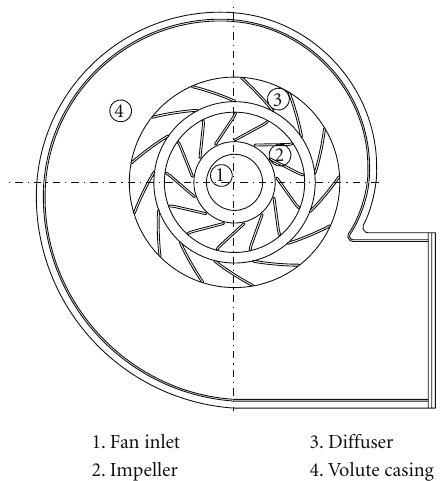
Figure 1: Model of the centrifugal fan used in the analysis.